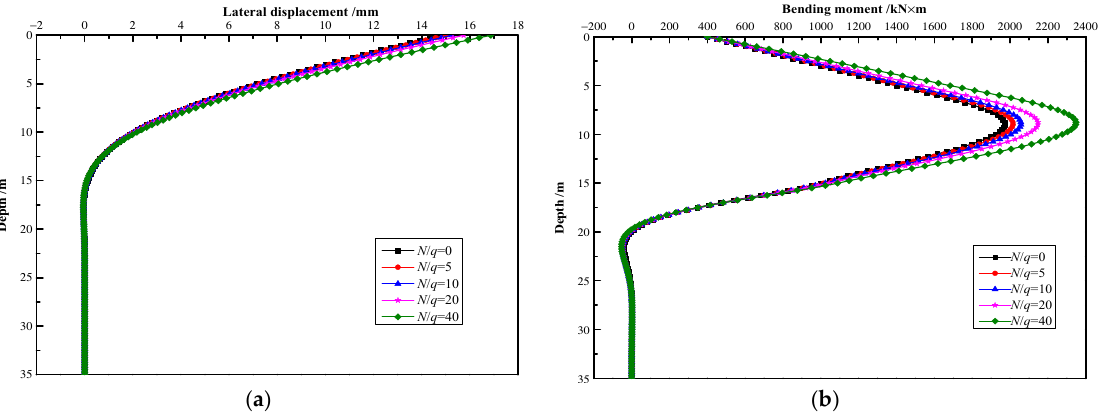
Figure 15. Influence of vertical load on lateral behavior of pile shaft. ( a ) Lateral displacement/mm; ( b ) bending moment/kN × m.